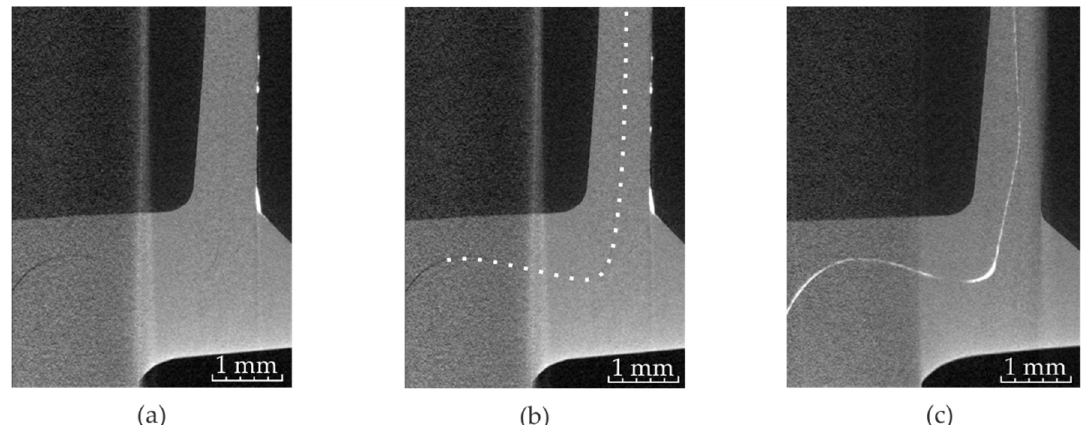
Figure 2. Detail of a computed tomography (CT) image of a clinch point with poorly visible sheet–sheet interface ( a ) and the same CT image with the assumed interface marked with a white dotted line ( b ). The same detail with copper varnish (applied on both sheets) in the sheet–sheet interface ( c ).